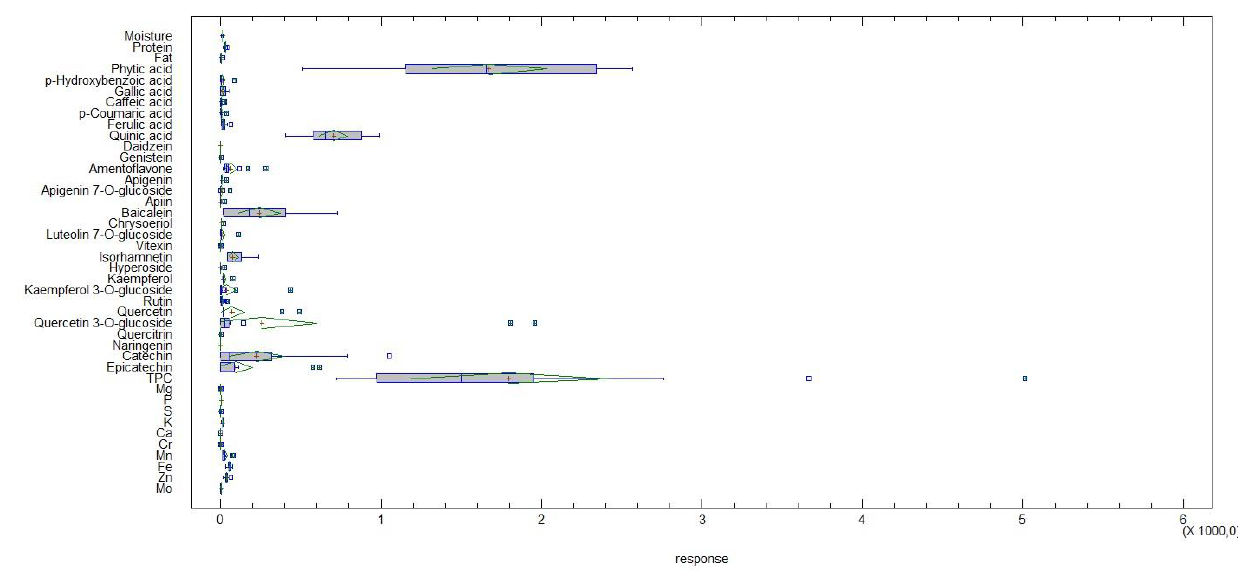
Figure 5. Box and Whisker Plot for 40 variables studied in pulse samples.